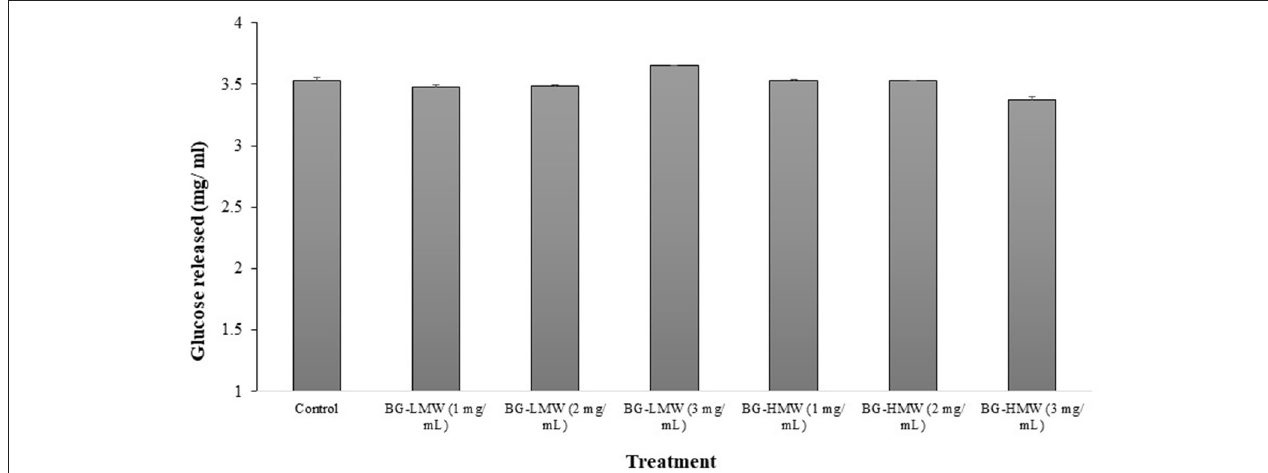
FIGURE 2 | Effect of BG on mammalian intestinal alpha-glucosidase activity. Maltose (30 mg/mL) was mixed buffer (control) or buffers containing different amounts barley BG (BG-HMW: 650,000 average molecular weight; BG-LMW: 229,000 average molecular weight). Data are mean + standard deviation ( n = 6). No statistical difference ( p < 0.0001) was observed between means of treatment